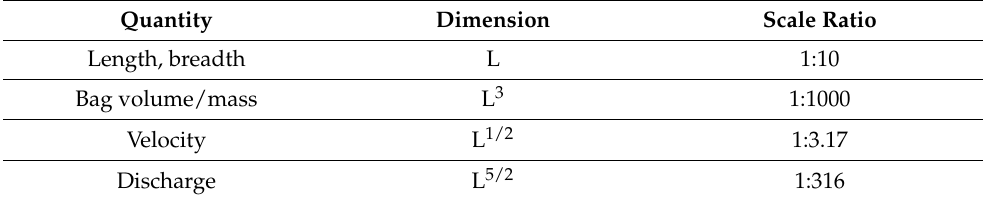
Table 1. Scale Ratio for Experimental